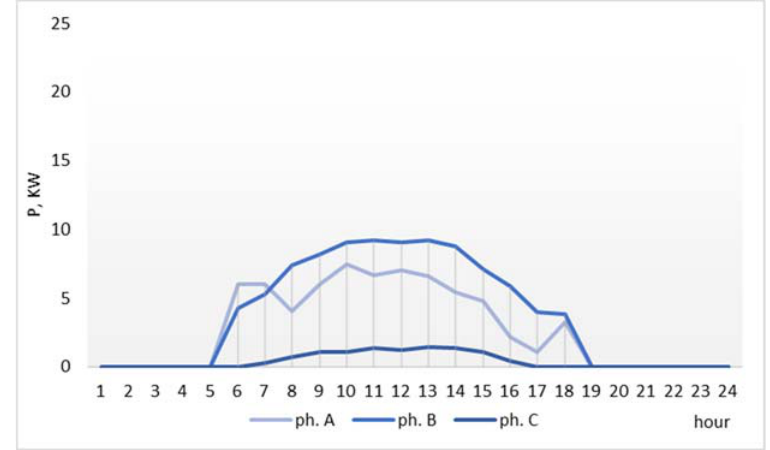
Figure 8. Prosumer surplus in network R28.